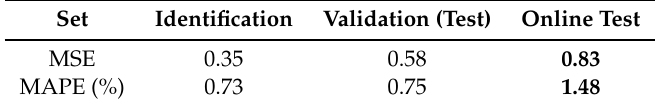
Table 2. Results from the identification and validation of ARMAX model for the development board. Set Identification Validation (Test)